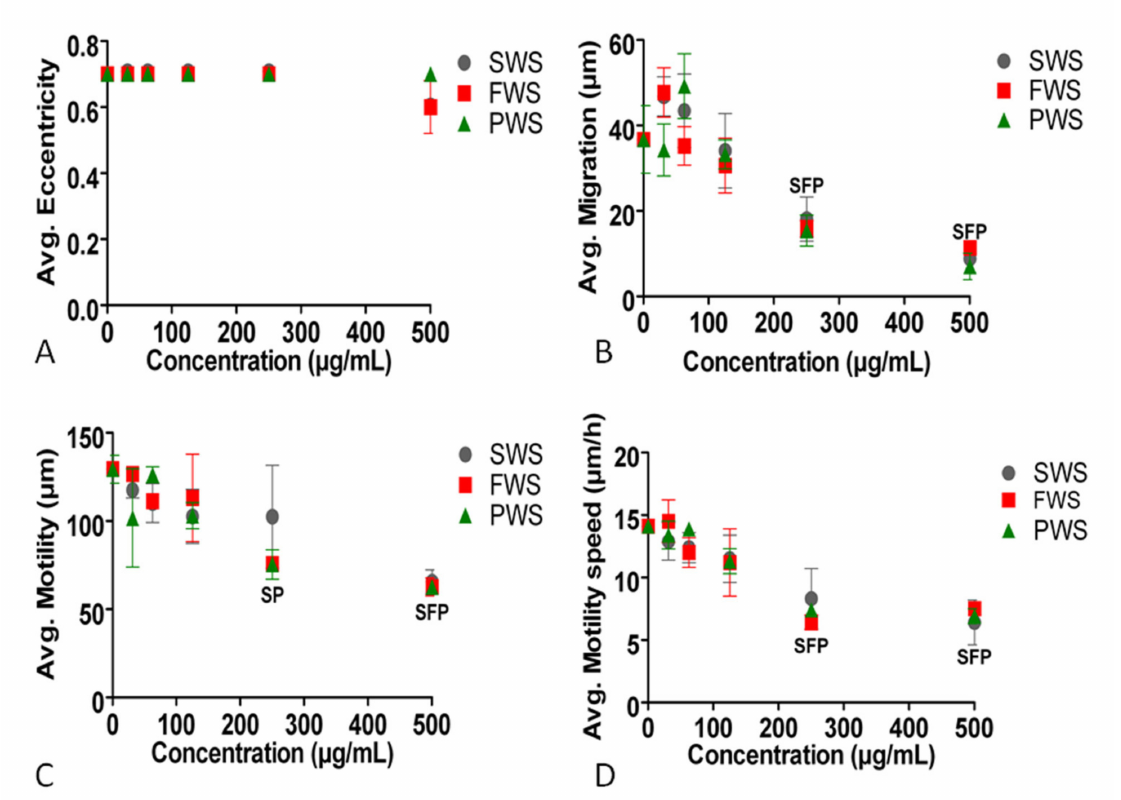
Figure 5. Effects of three types of water-soluble particulate pollutants from biomass burning on: ( A ): eccentricity, ( B ): migra- tion, ( C ): motility, and ( D ): motility speed of A549 cells. Significant differences at p ≤ 0.05 between the particles and the control are represented by F for FWS, S for SWS, and P for